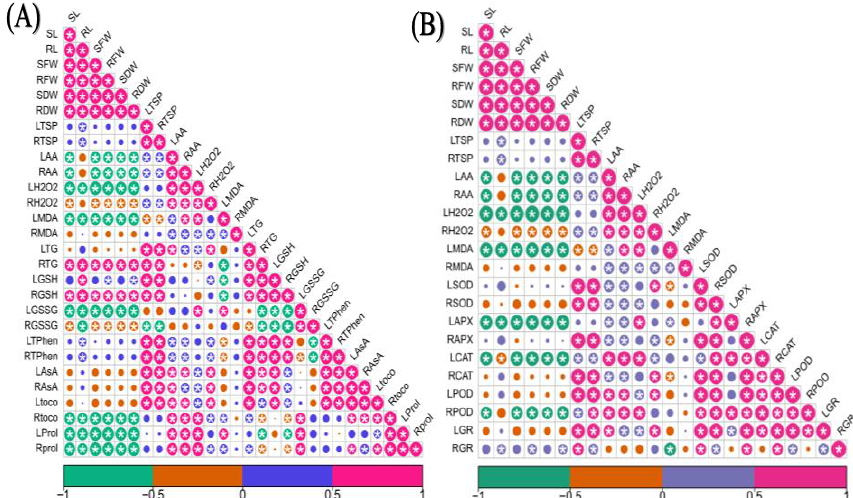
Figure 5. Pearson correlation analysis of different measured attributes of barley genotypes (B10008 and B14011) with non-enzymatic ( A ) and enzymatic ( B ) antioxidants modulated by application of silicon through rooting media under salinity stress. Asterisk (*) denotes significance of the interaction at p ≤ 0.05. Color of circles corresponds, i.e., Red: highly positive; Purple: slightly positive; Green: highly negative; Brown: slightly negative. Circle intensity or size shows the strength of correlation: stronger (Bigger) or weaker (Smaller). SL: shoot length; RL: root length; SFW: shoot fresh weight; RFW: root fresh weight; SDW: shoot dry weight; RDW: root dry weight; LTSP: leaf total soluble protein; RTSP: root total soluble protein; LAA: leaf free amino acids; RAA: root free amino acids; LH 2 O 2 : leaf hydrogen peroxide; RH 2 O 2 : root hydrogen peroxide; LMDA: leaf malondialdehyde; RMDA: root malondialdehyde; LTG: leaf total glutathione; RTG: root total glutathione; LGSH: leaf reduced glutathione; RGSH: root reduced glutathione; LGSSG: leaf oxidized glutathione; RGSSG: root oxidized glutathione; LTPhen: leaf total phenolics; RTPhen: root total phenolics; LAsA: leaf ascorbic acid; RAsA: root ascorbic acid; Ltoco: leaf α-tocopherol; Rtoco: root α-tocopherol; LProl: leaf proline; Rprol: root proline; LSD: leaf superoxide dismutase; RSOD: root superoxide dismutase; LAPX: leaf ascorbate peroxidase; RAPX: root ascorbate peroxidase; LCAT: leaf catalase; RCAT: root catalase; LPOD: leaf peroxidase: RPOD: root peroxidase: LGR: leaf glutathione reductase; RGR: root glutathione reductase.